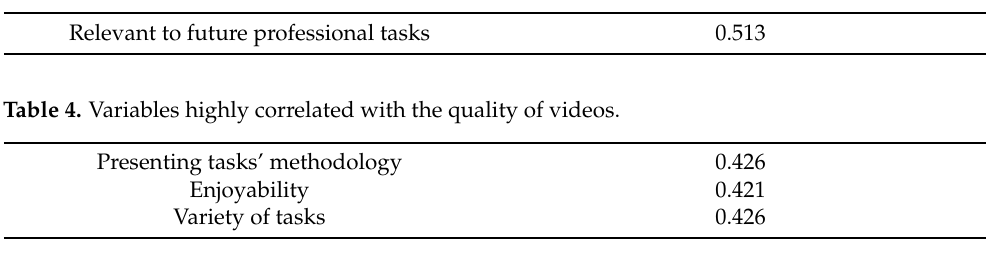
Table 3. Variables highly correlated with the 15th assignment.